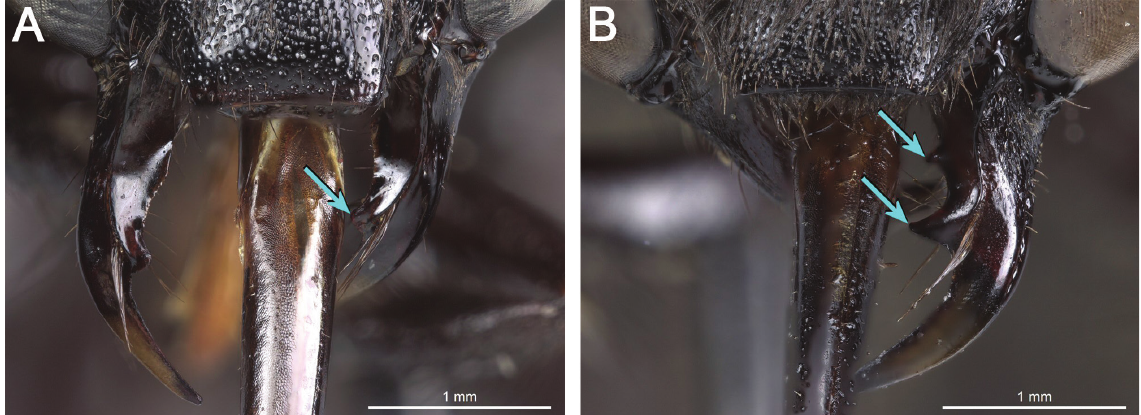
Fig. 14. Mandibles of female. A . Brachymelecta larreae (Cockerell, 1900) (CNC 891712), each mandible has a single inner (preapical/almost submedial) tooth (blue arrow). B . B. interrupta (Cresson, 1872) (CNC 891714), each mandible has both an inner basal tooth as well as an inner preapical (almost submedial) tooth (blue